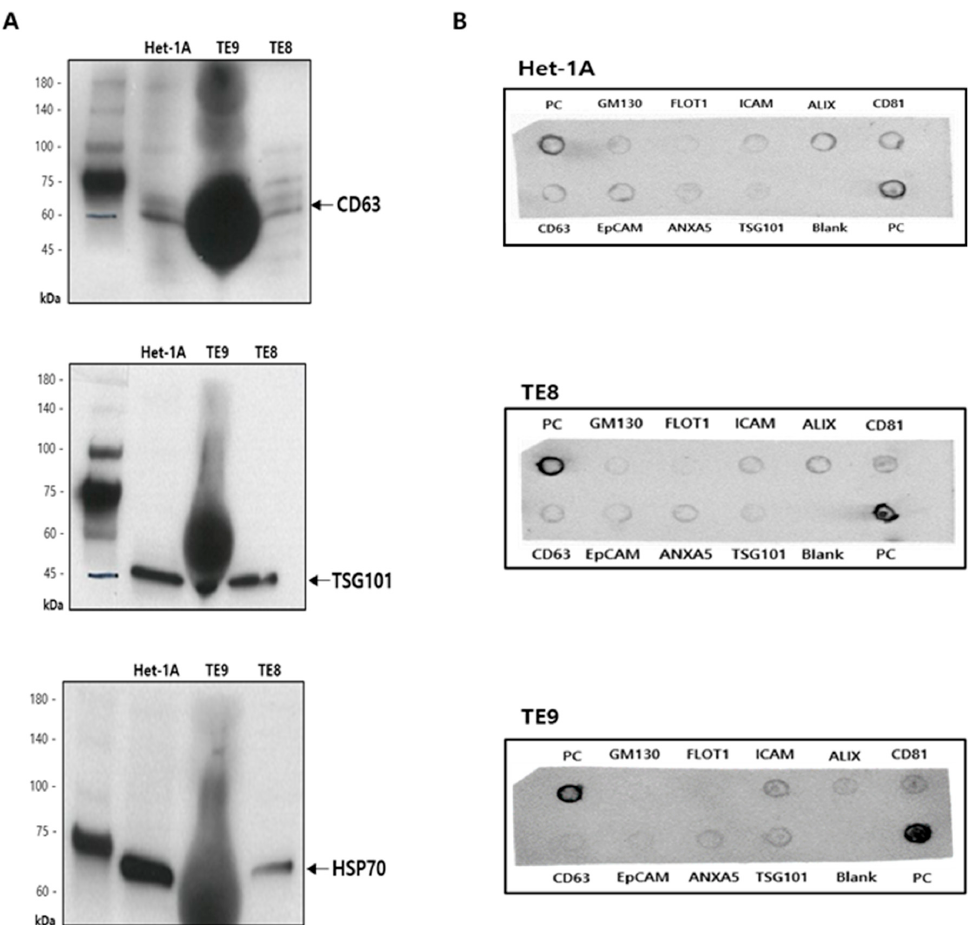
Figure 3. Characterization of exosomes in esophageal epithelial cell and esophageal squamous cell carcinoma cell lines. ( A ) Expression of exosome markers detected with Western blot analysis (CD63, TSG101, and HSP70). ( B ) Representative Exo-Check exosome antibody array for detecting exosomal markers (FLOT1, ICAM, ALIX, CD81, CD63, EpCAM, ANXA5, and TSG101) and for assessing cellular contamination (Golgi marker GM130) and positive control